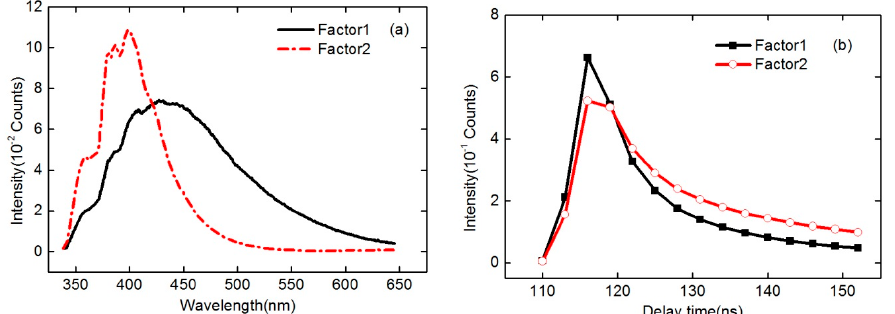
Figure 7. Intensities of the decomposed factors ( F = 2) of PARAFAC as a function of emission wavelength ( a ) and delay time ( b ), respectively.